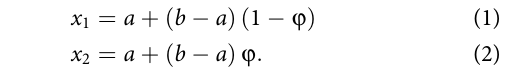
algorithm as one of the previous intermediate points is